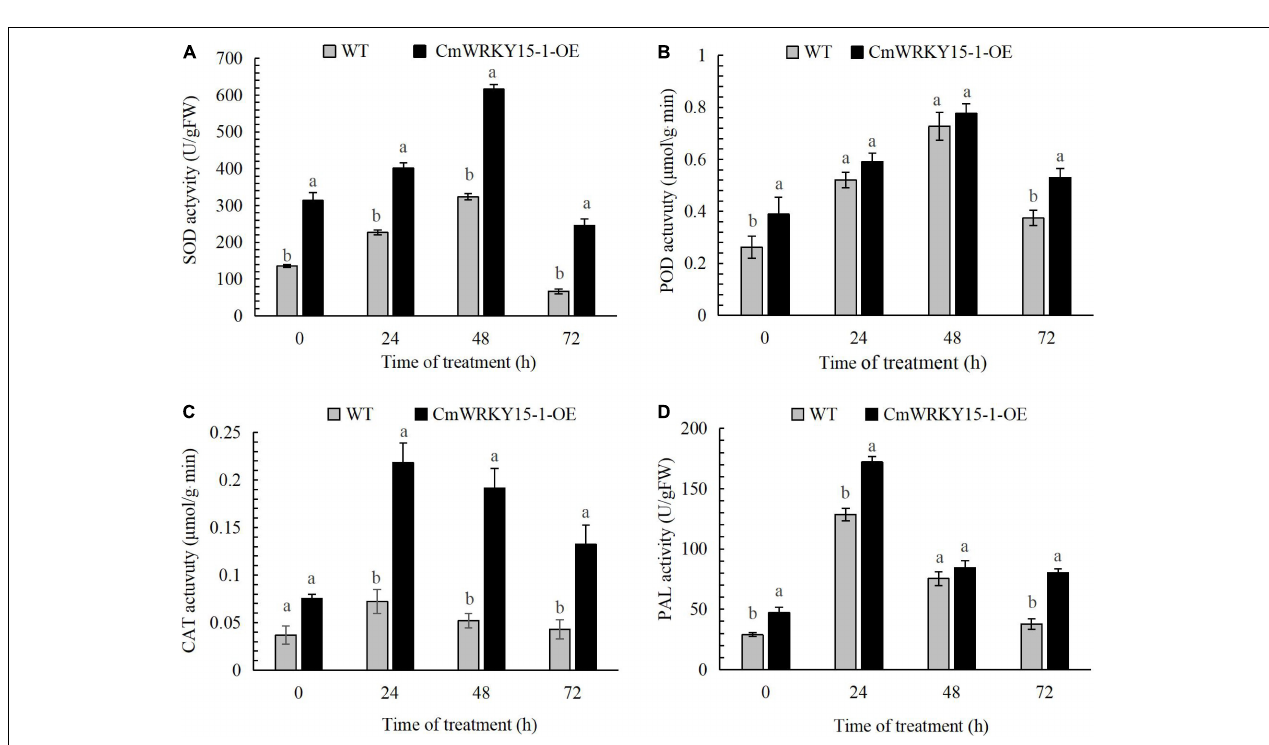
FIGURE 2 | Activity of defense enzymes in WT and CmWRKY15- 1 - OE lines of ‘Jinba.’ (A) SOD activity. (B) POD activity. (C) CAT activity. (D) PAL activity. Error bars show SD of three replicates. Different letters demonstrate significantly different by Duncan’s multiple range test at p < 0.05.